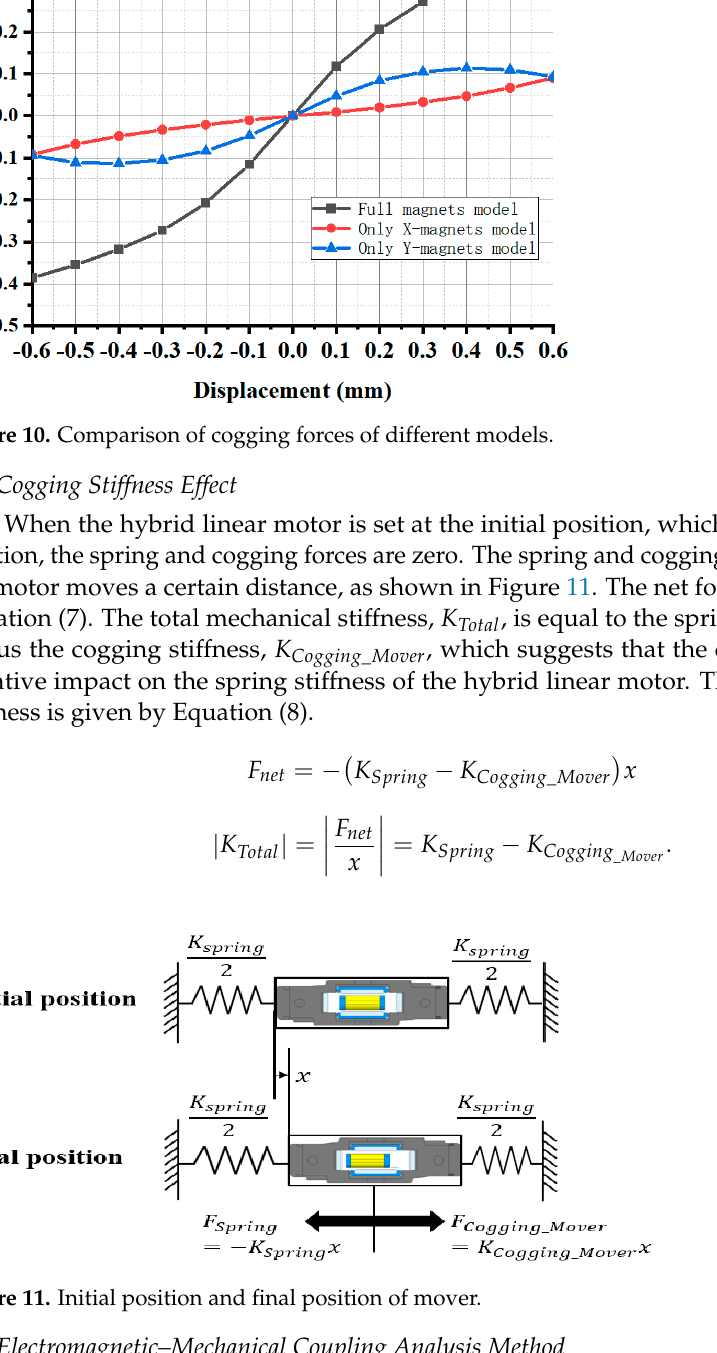
Figure 9. Samples with open case: ( a ) sample preparation process and ( b ) magnet settings.